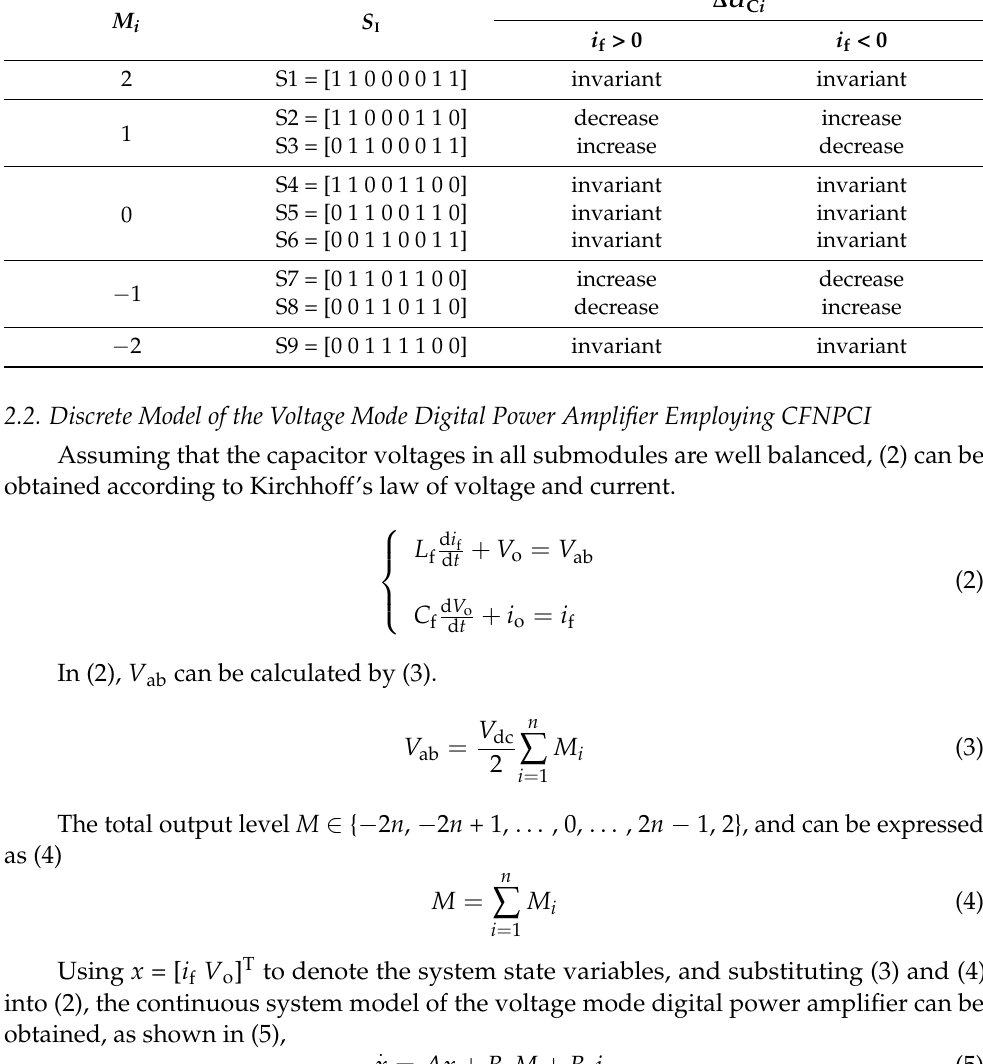
Table 1. Relationship between ∆ U C i , M i , i f and S i . M i